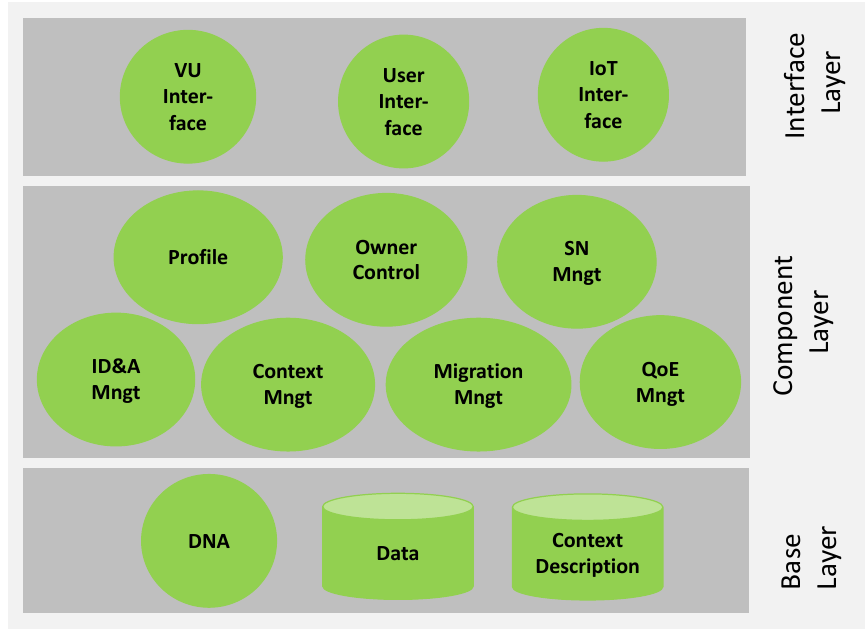
Figure 5. The functional layers of the VU